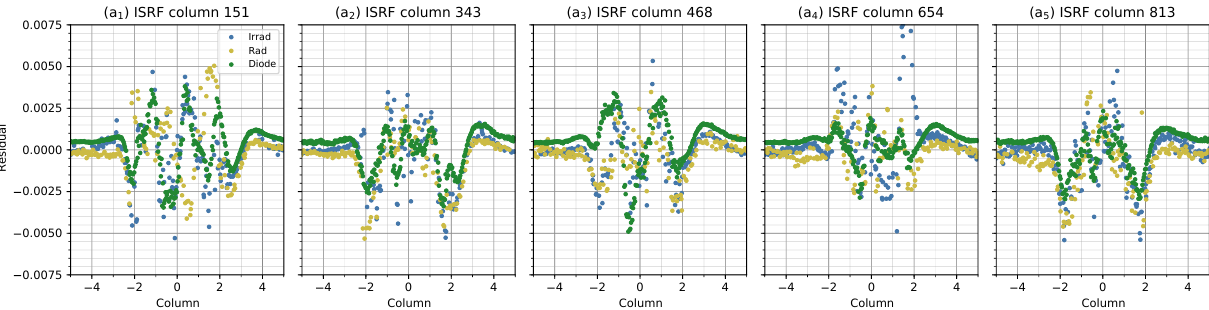
Figure 14. Differences between the local ISRF and the smoothed ISRF for irradiance, radiance and diode-laser measurements. This figure illustrates that smoothed ISRF data agree well with the local ISRF data presented in Figs.